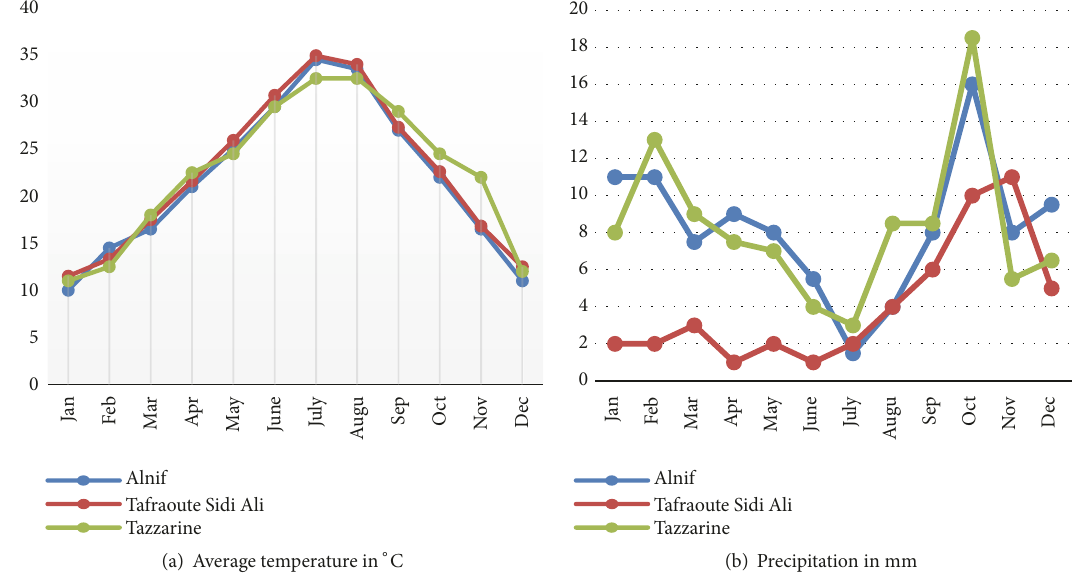
Figure 3: Climatological data (average temperatures and precipitation) of the locations where the three Henna varieties studied are planted [15,